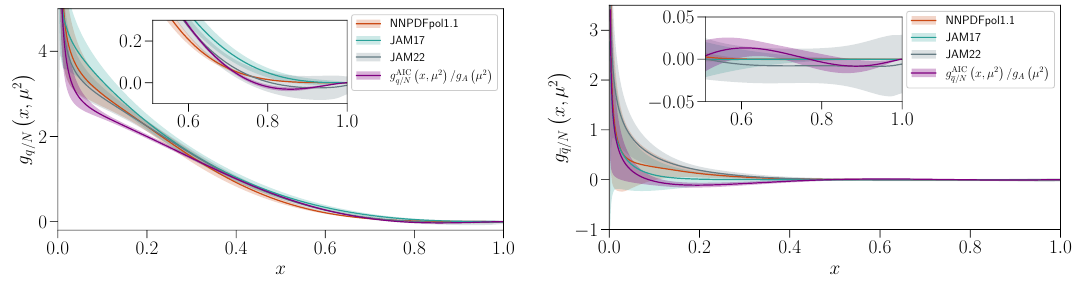
(cid:0) (cid:1) (cid:0) (cid:1) x, µ 2 /g A µ 2 (left) and g q/N